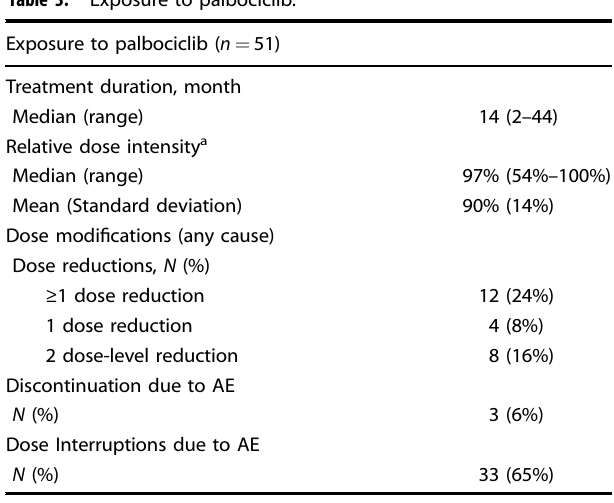
Table 3. Exposure to